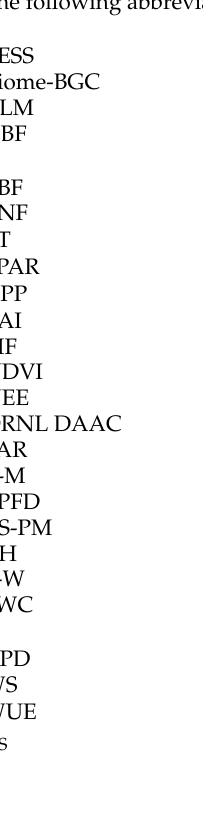
Table S1: Site Information for the eddy covariance (EC) flux sites in this study, including plant functional type (PFT), site identifier (Site ID), latitude (Lat), longitude (Lon), data period, country, and references. Figure S1: Performances of the SWH model in estimating ET (a,b) and GPP (c,d) at 32 sites, which were used for calibration (a,c) and the remaining sites for validation (b,d). Figure S2: Comparisons of eight-day ET (a) and GPP (b) derived from eddy covariance and estimated by the regionalized SWH model, which was driven by the 10-km interpolated meteorological products. Figure S3: Correlation between the model performance on GPP simulation and ET simulation. R2_GPP and R2_ET are the determinant coefficient of the relationship between modeled and measured GPP and ET,